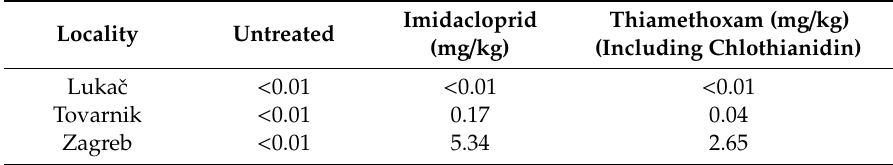
Table 3. Residues of neonicotinoids (mg / kg) in soil samples taken from field sites at the end of the growing season 2016 (i.e., 180 days’ post planting),